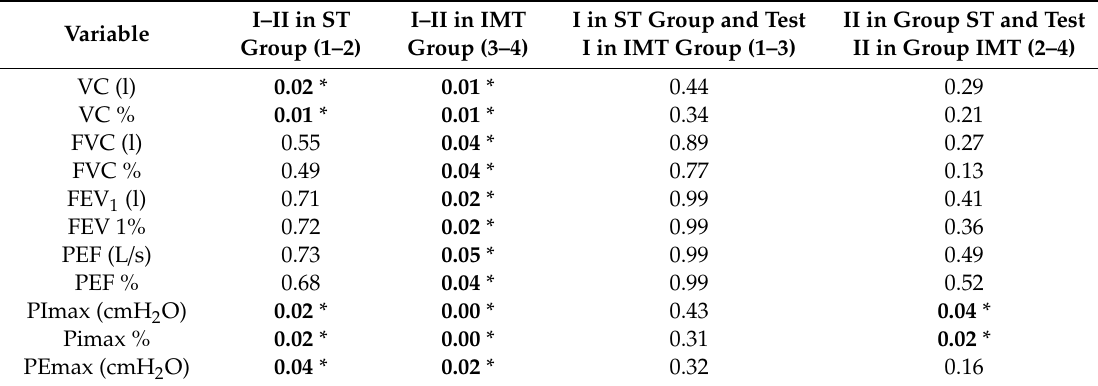
Table 5. p -values for Duncan’s post hoc test for selected ventilation parameters and PImax and PEmax.